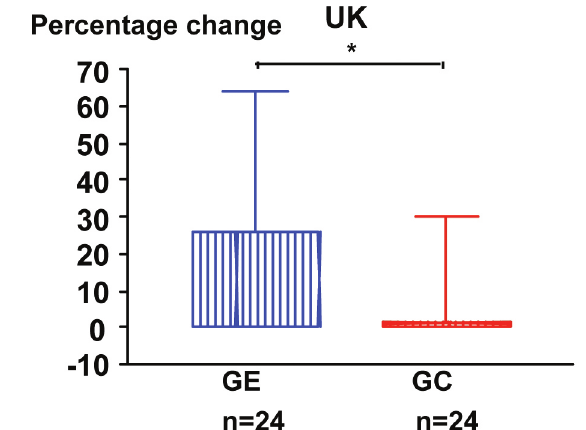
FIGURE 5 - Percentage change ± SD in 24-hour urine potassium excretion (UKV) between time 0 and 270 (days) in the total experimental group (EGT) and total control group (CGT). *p<0.05. EGT n=24 (24 patients of the total experimental group